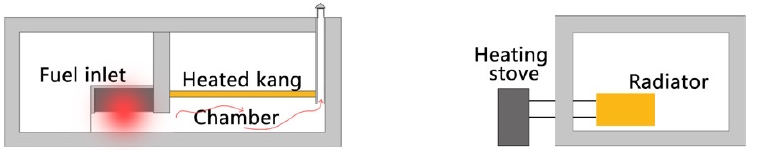
Figure 10. Schematic diagram of a traditional heating system section.